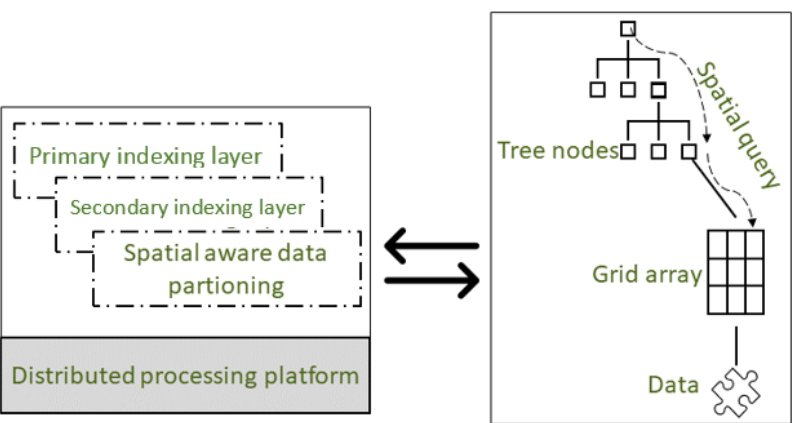
Figure 4. Multilayer structure of distributed processing platform.